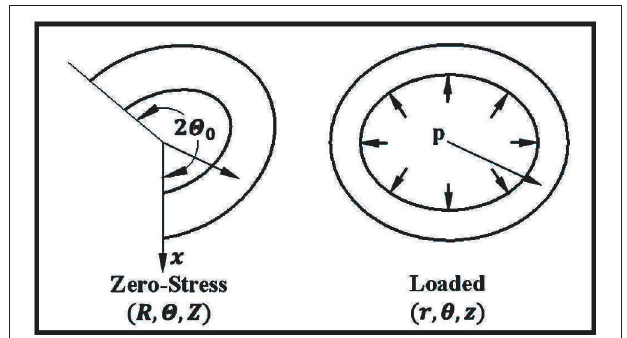
FIGURE 1 | Schematics showing an artery in the zero-stress, and loaded states as well as the definitions of the coordinates. The opening angle of the artery is designated as (2 π − 2 2 0